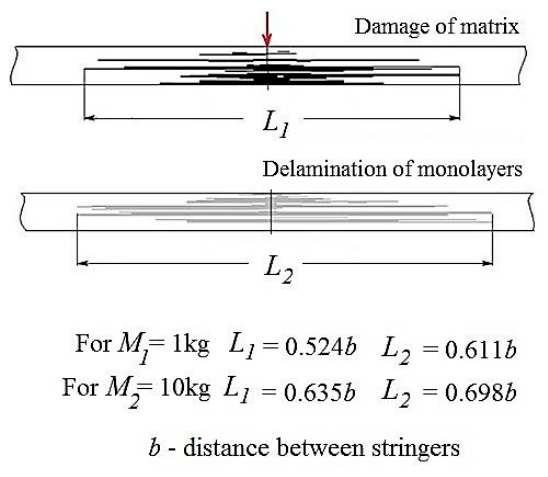
Figure 6. Impact damage zones in the longitudinal direction. M 1 , M 2 —the weights of different impactors; L 1 —the size of matrix damage area; L 2 — the size of delamination area.